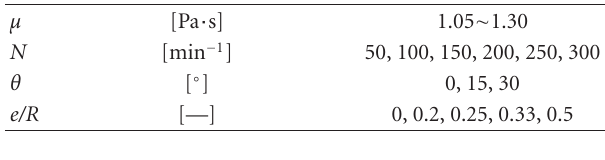
Table 1: Experimental condition.